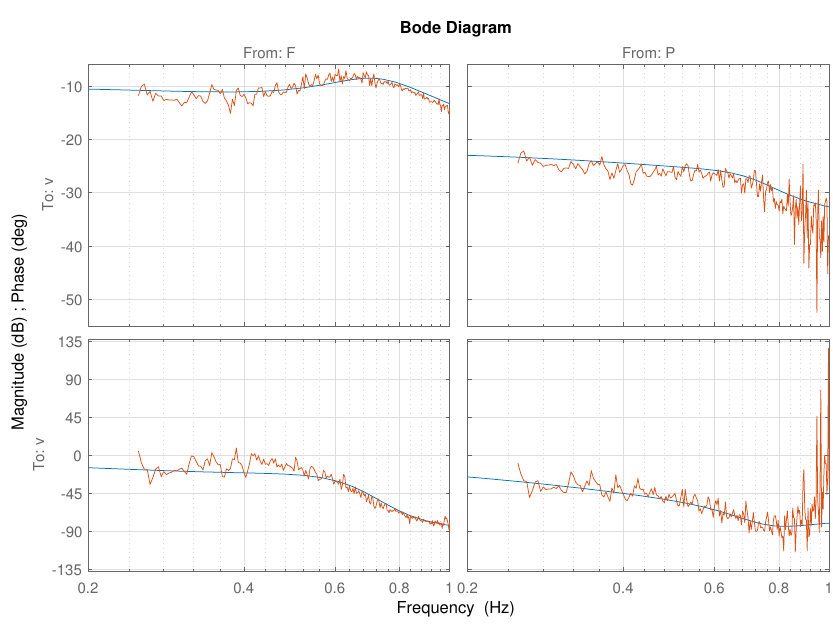
Figure 35. Comparison of MISO parametric and dual SISO nonparametric models.